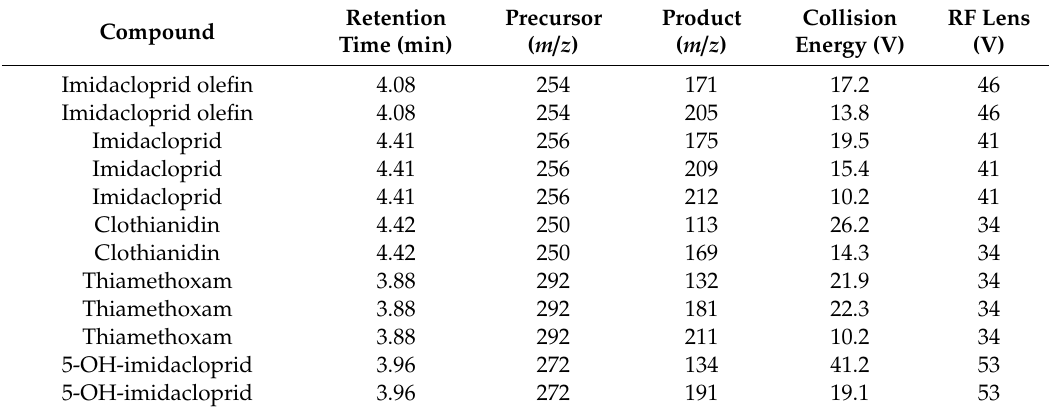
Table 1. Select reaction monitoring (SRM) table of three neonicotinoids and their metabolites .